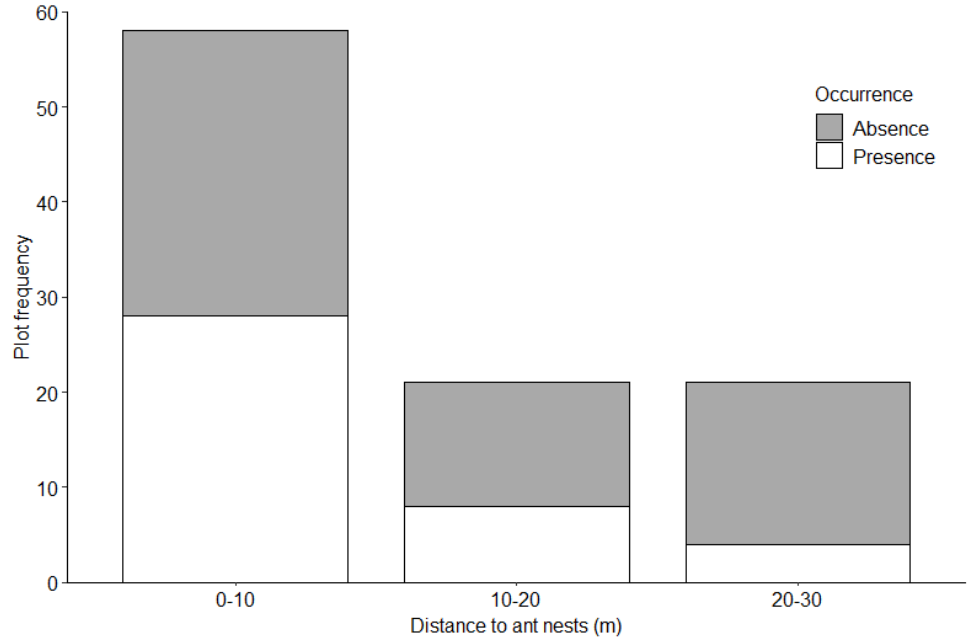
Figure 6. Chinese pangolin foraging burrow distribution by distance to ant nests in Chandragiri Municipality, Nepal. Table 2. Generalized linear mixed model estimates and 95% confidence limits describing the Chinese pangolin occurrence in Chandragiri Municipality, Nepal. Variables include slope gradient (°), forest canopy coverage (%), distance to water source (m), road (m), agricultural land (m), and ant nests (m), no. of ant nests, and tree abundance were included in model construction. Significant effects ( p < 0.05) are in bold.